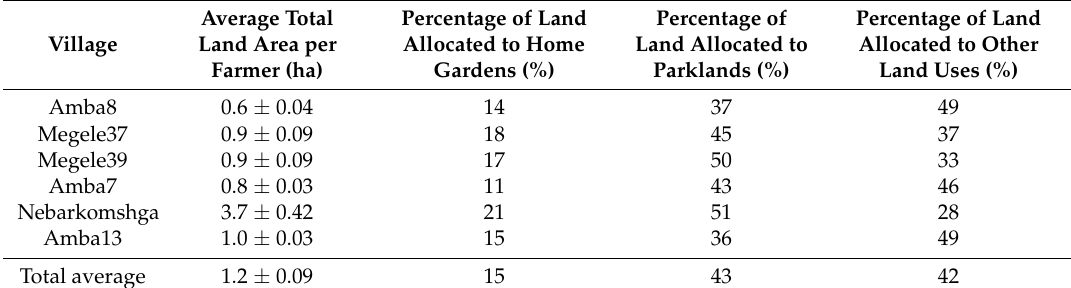
Table 2. Share of total land area allocated to home gardens, parklands and other land uses per farmer in Assosa district, western